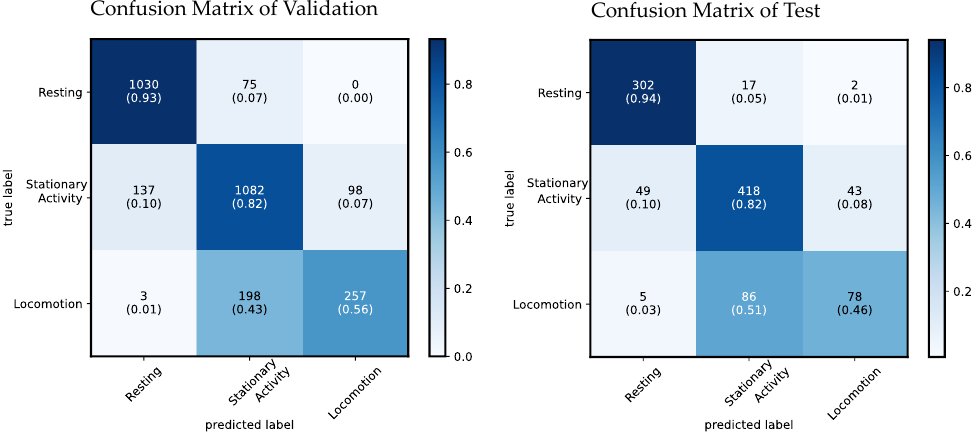
Figure 6. This figure shows the confusion matrix of an optimizable ensemble classification model which computes eleven features. The numbers in the boxes show the amount of samples. The numbers in the brackets below show the relative amount of samples. Validation results are displayed on the left and test results on the right.